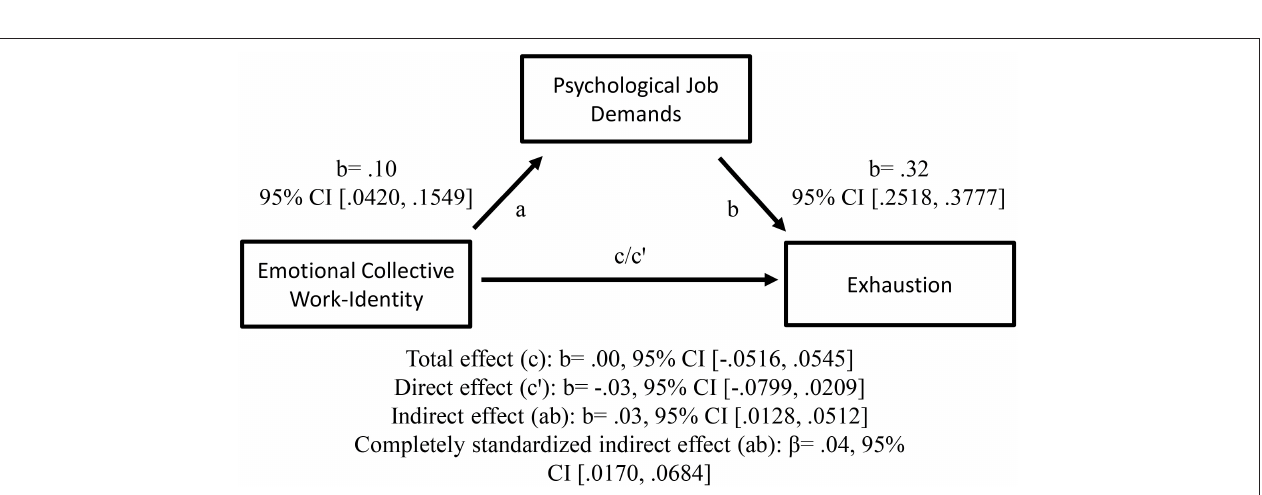
FIGURE 3 | Cognitive personal work-identity as a predictor of exhaustion, mediated by psychological job demands. The confidence interval (CI) for the indirect- and completely standardized indirect effect is a BC bootstrapped CI based on 5,000 samples.